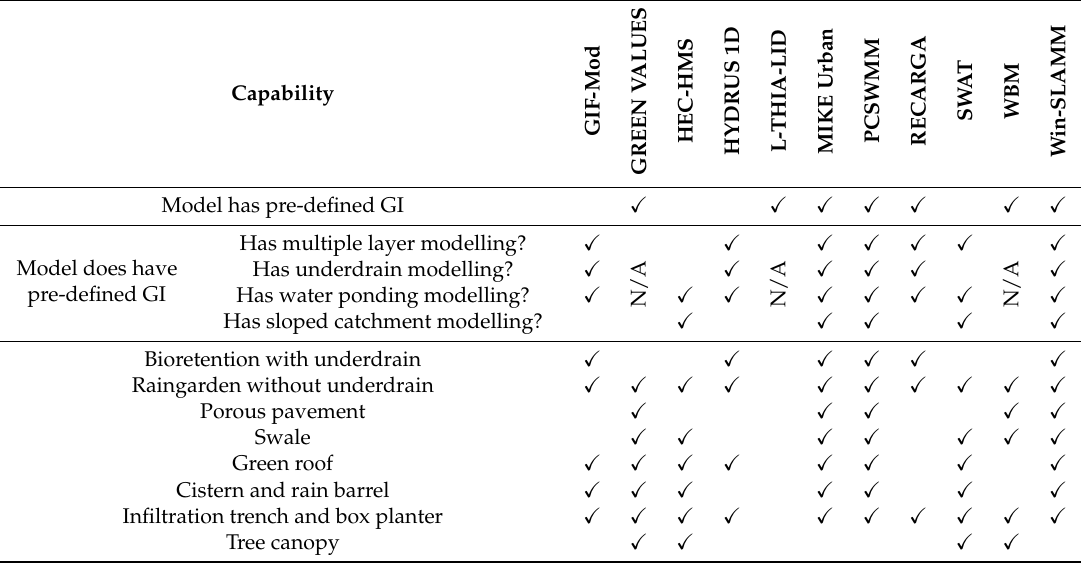
Table 4. Capability of the selected models in modelling different types of